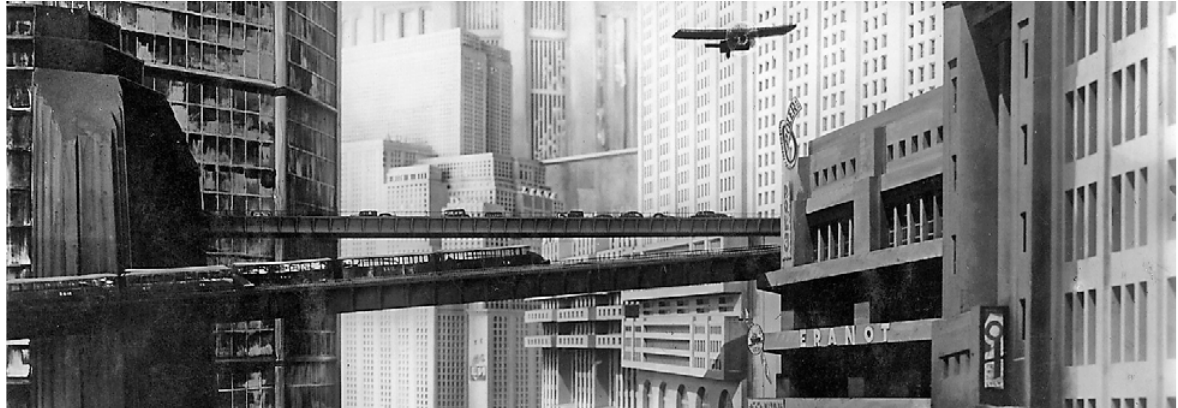
fig. 4. fly-over bridges connecting buildings in